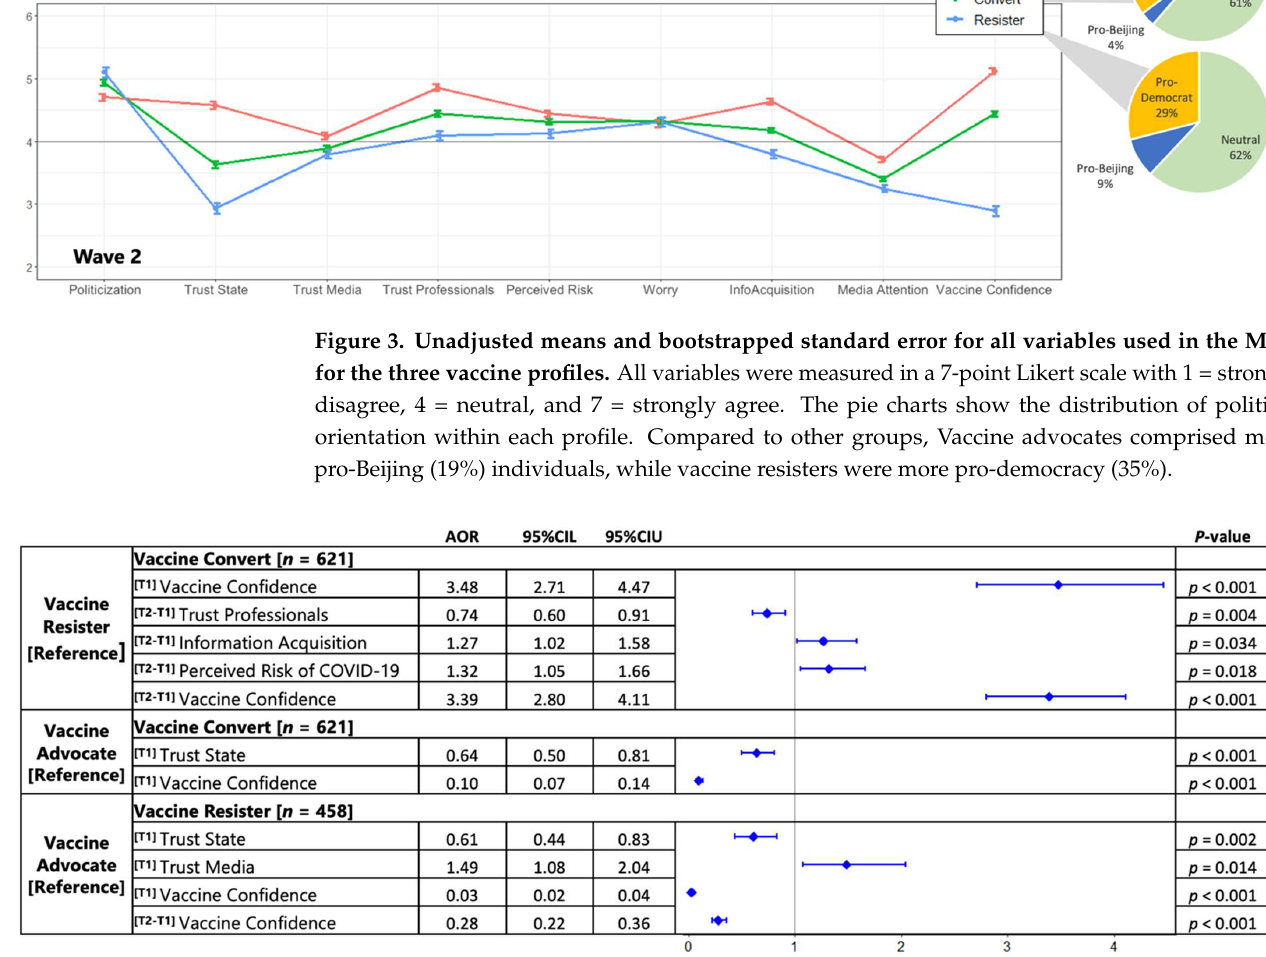
Figure 4. Forest plots of results from MLR models. AORs were adjusted for covariates of Wave 1 age, gender, education, income, number of children, and region. Factors include Wave 1 trust, information consumption, and risk perception, marked as [T1]; and their difference from Wave 2, marked as [T2-T1]. The vaccine resistant group served as a reference in both comparisons. Wald Confidence Intervals (CIs) are presented for the MLRs. Exact p values are presented when CIs do not include 1.